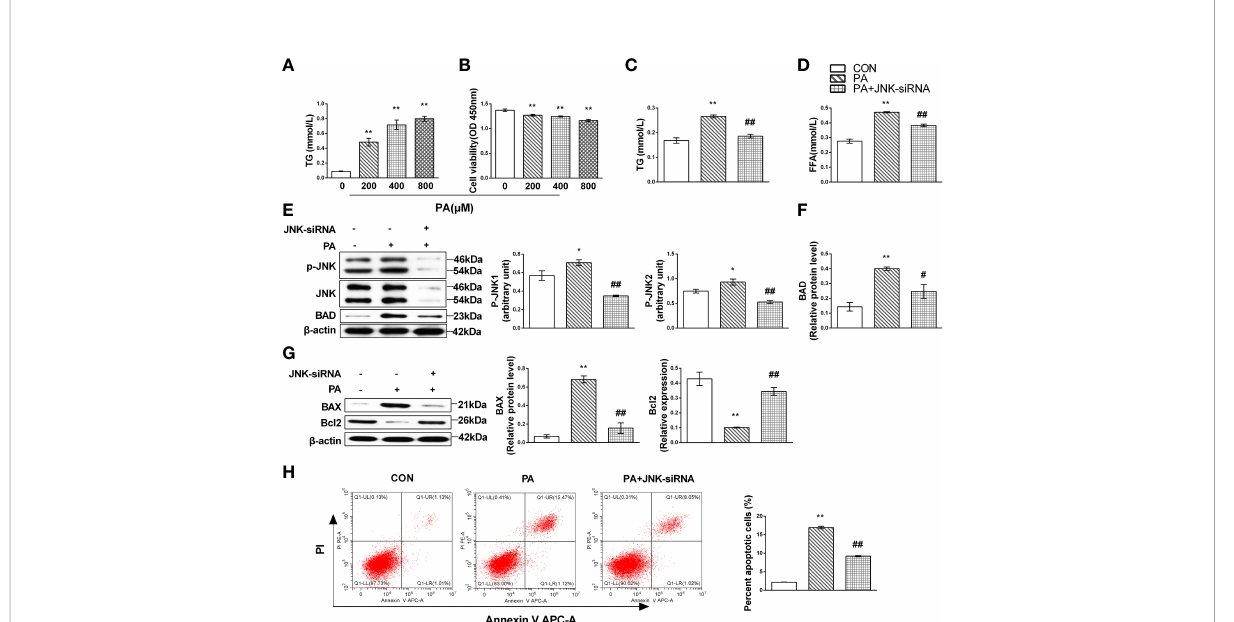
FIGURE 4 JNK activation might contribute to liver lipotoxicity following lipid oversupply. HepG2 cells were treated with the gradient concentrations of PA for 24 h; lipid accumulation was identi fi ed as cellular TG content and cytotoxicity by CCK-8 assays in the culture supernatant (A, B) . HepG2 cells were cultured with 400 mmol/L PA for 24 h and then transfected with JNK-siRNA. TG (C) and FFA (D) content were measured. Expression levels of JNK (E) and Bcl family proteins (F, G) by Western blot analysis. Apoptotic cells were identi fi ed by fl ow cytometry ( n = 3 per each) (H) . Quanti fi cation of immunoblots is shown in the graphs below the blots ( n = 3 per group). M ± SEM. * P < 0.05 versus Con; ** P < 0.01 versus Con; # P < 0.05 versus PA; ## P < 0.01 versus PA.